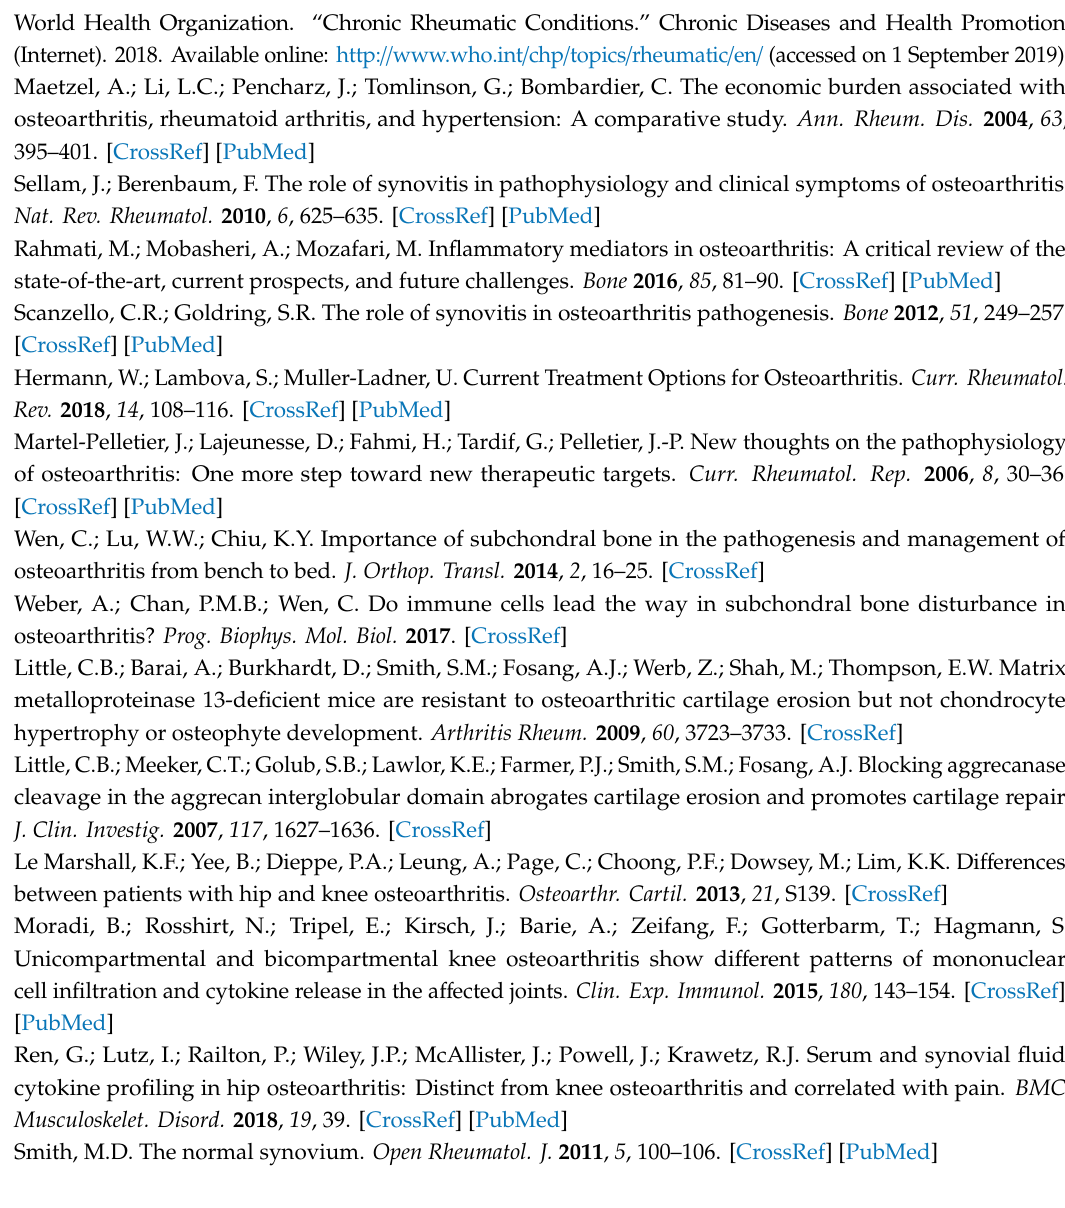
Figure S1: Cytokine expression comparison between Hip and Knee OA in patients with K&L score 3